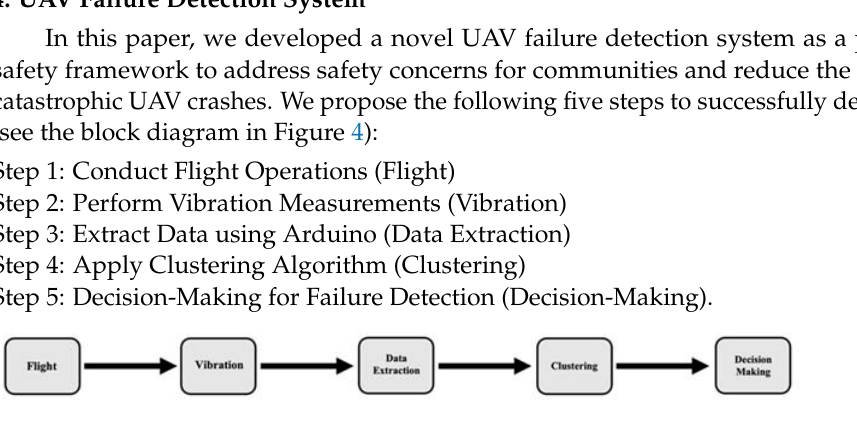
Figure 4. Block Diagram for Failure Detection Model.